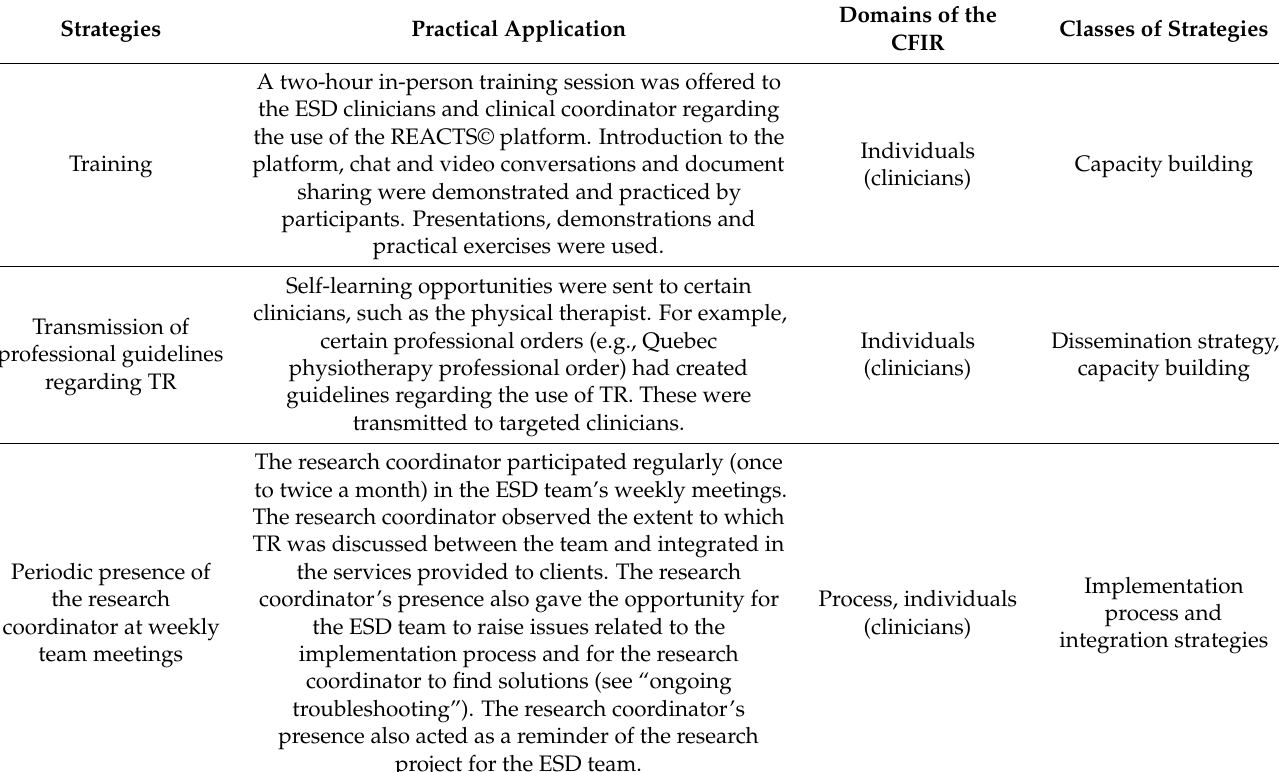
Table 1. Description and classification of the implementation strategies used during the pre-COVID- 19 period (November 2018 to February 2020) according to the Consolidated Framework for Imple- mentation Research [22] and Leeman et al.’s [25]